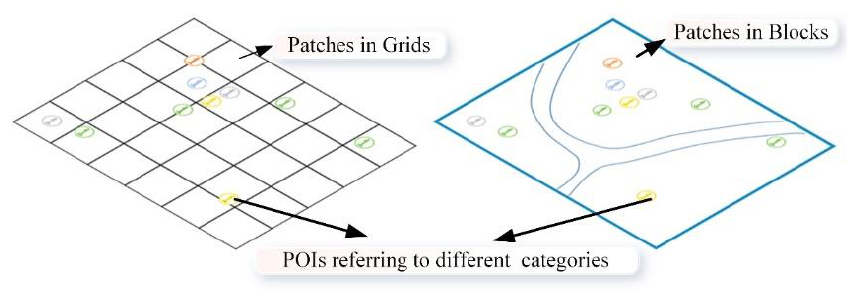
Figure 3. Patches diagrams in continuous grids ( left ) and road level blocks ( right ).